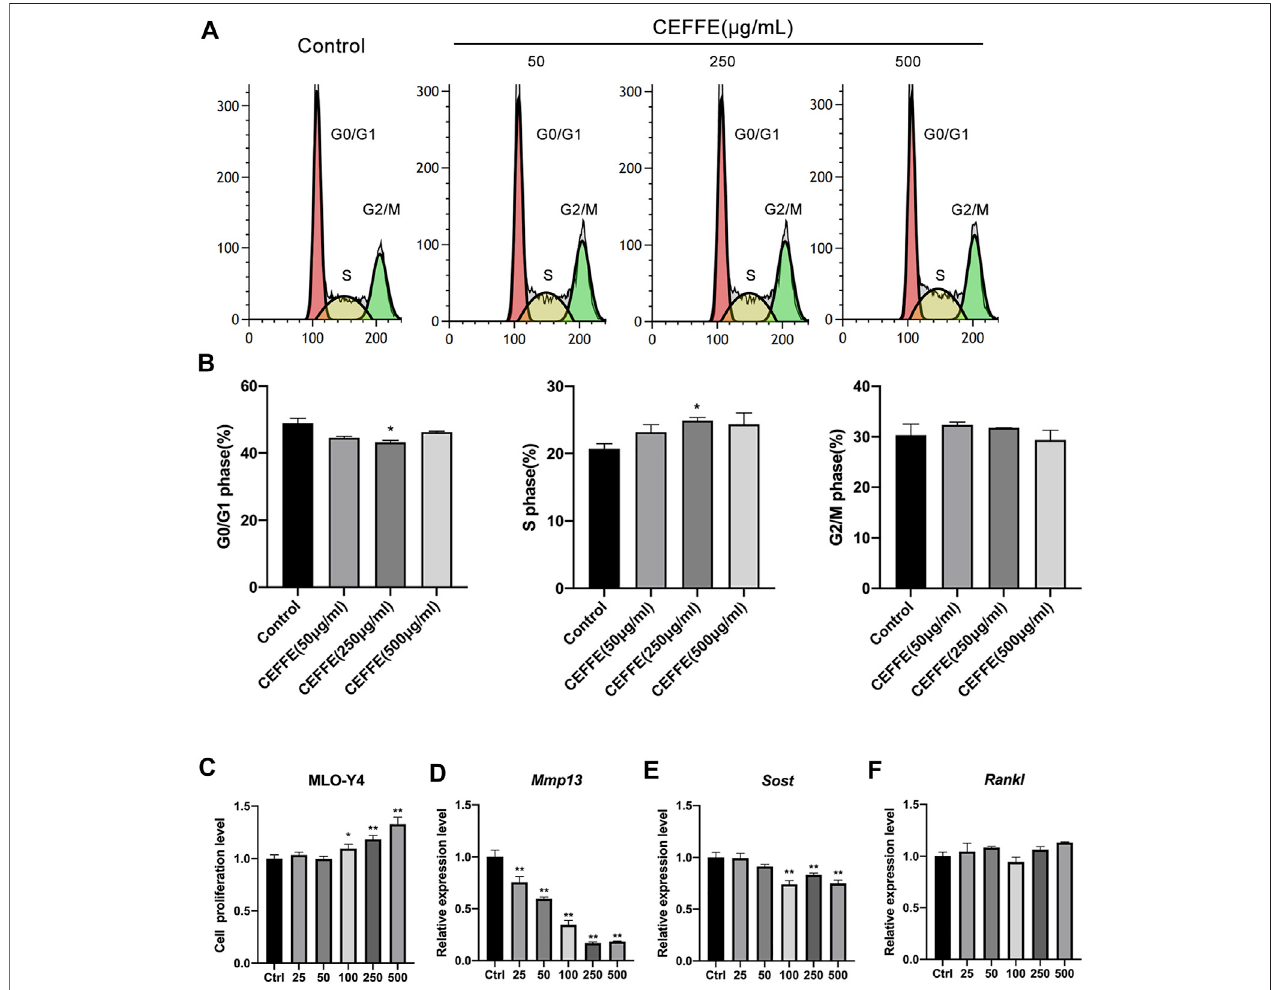
FIGURE 4 | CEFFE promotes the proliferation of osteocytes in vitro . Incubation with various concentrations of CEFFE promoted MLO-Y4 proliferation in a dose-dependent manner using fl ow cytometry (A,B) and CCK-8 (C) . CEFFE (250 μ g/ml) promoted the viability and proliferation of MLO-Y4 cells. Expression of osteocyte-speci fi candremodeling-relatedgenes,Mmp13 (D) ,Sost (E) ,andRankl (F) inMLO-Y4cellstreatedwithdifferentconcentrationsofCEFFEfor24h.* p < 0.05, ** p < 0.01 vs. control.